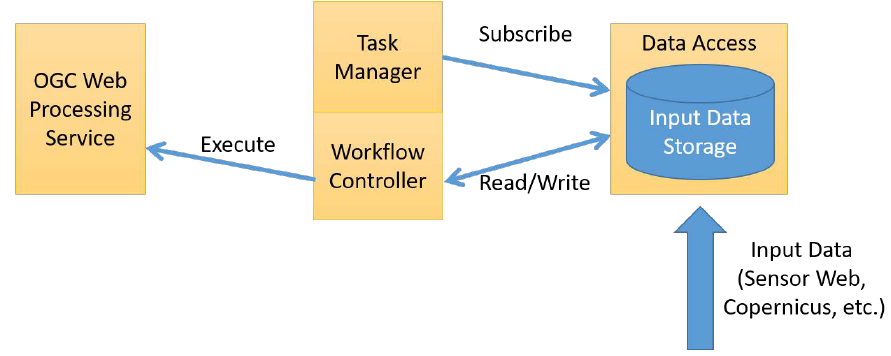
Figure 9. Simplified Overview of the WaCoDiS Workflow